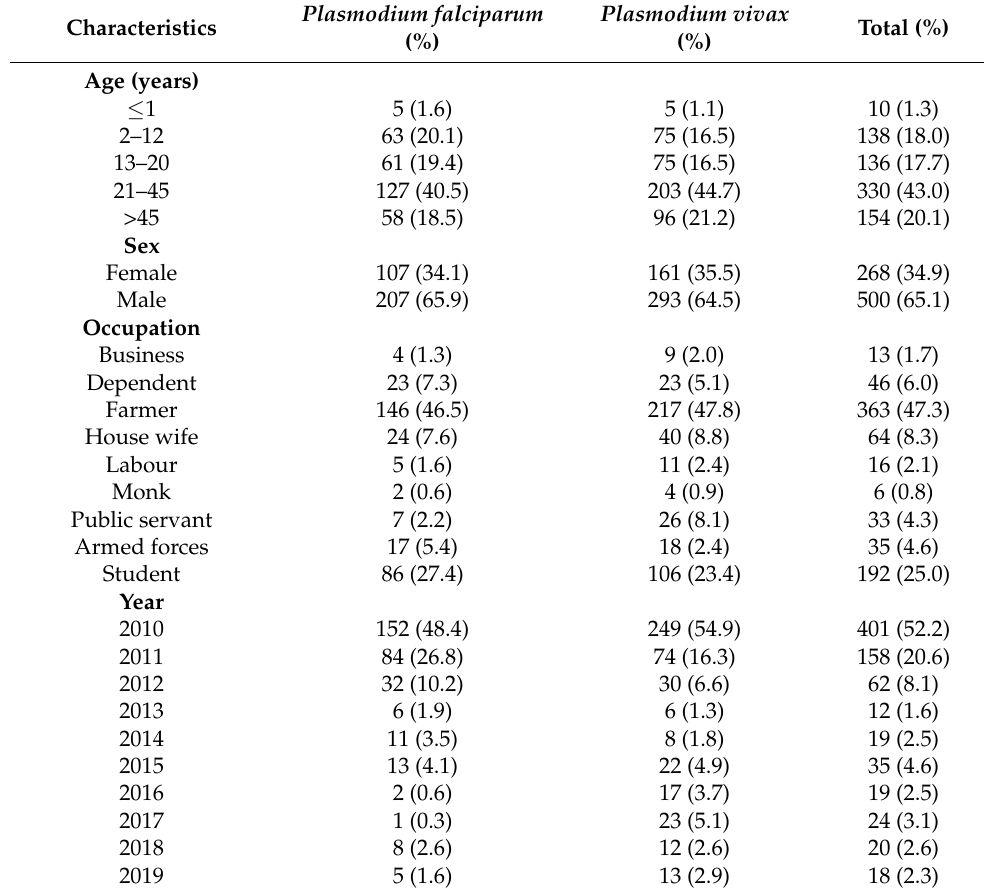
(Table 1). The yearly annual parasite incidence (API) of sub-districts (cases of sub-district divided by population per 1000) is shown in Supplementary Figures S1 and S2. Table 1. Socio-demographic characteristics of Plasmodium falciparum and Plasmodium vivax during the study